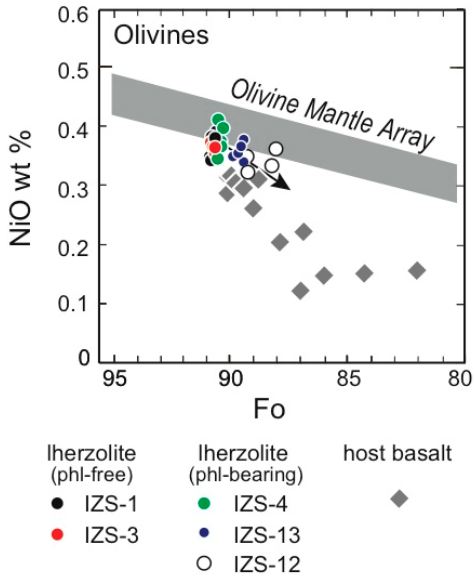
Figure 6. Fo vs. NiO relations of olivine. Olivine-Mantle Array (mantle peridotite range) is after Takahashi [69]. Note that the olivines in the phlogopite-bearing lherzolite are slightly lower in Fo and NiO content. Note that olivine has been altered in one of our samples (IZS-06). The arrow indicates a possible metasomatic trend. Minerals 2018 , 8 , x FOR PEER REVIEW